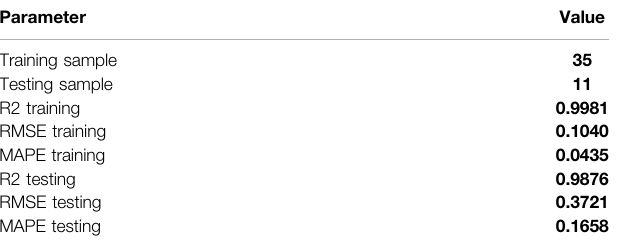
TABLE 7 | Statistical data and parameters for selected GEP model.